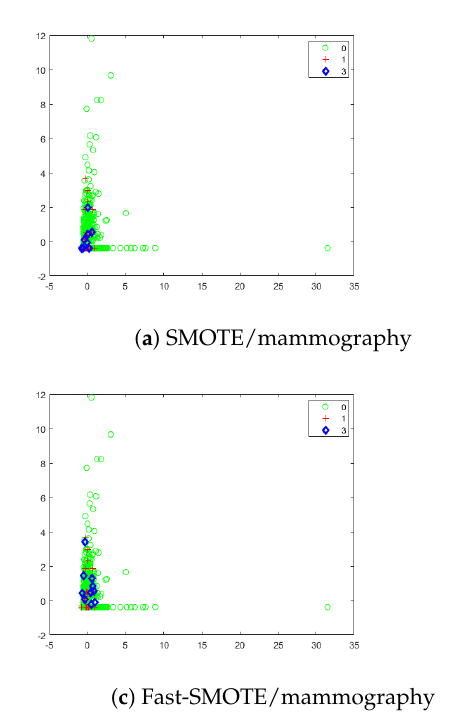
Figure 1. Synthetic objects (blue diamonds) generated by SMOTE ( a ), NDO ( b ), and Fast-SMOTE ( c ) over a 2-D projection of the dataset Mammography. Green circles represent objects of the majority class, and red crosses represent objects of the minority class.